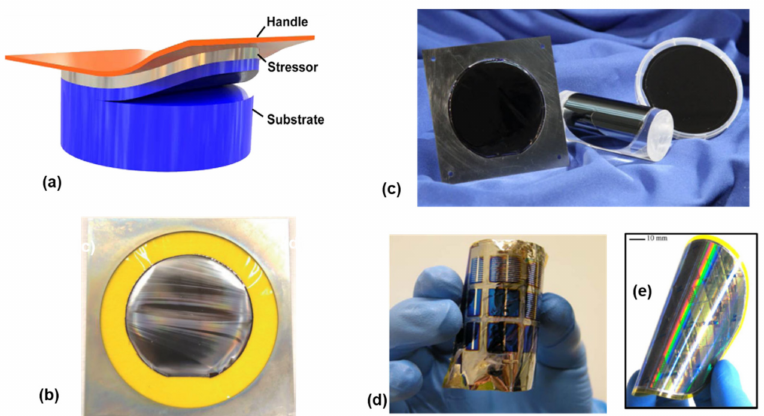
Figure 8. ( a ) Sketch of the mechanical spalling. Adapted from [74]. ( b ) Optical image of the released GaN film. Adapted with permission from [73]. Copyright IOP Science, 2013. ( c ) Optical images of Si on plastic mounted in a handling frame, 8 µ m thick III–V multijunction layers on tape and mounted on a cylinder, and the bulk Si substrate from which the 20 µ m thick layer was removed (from left to right). ( d ) Solar cells. Adapted with permission from [71]. Copyright IEEE, 2016. ( e ) flexible CMOS circuits fabricated by spalling techniques. Adapted with permission from [76]. Copyright American Chemical Society,